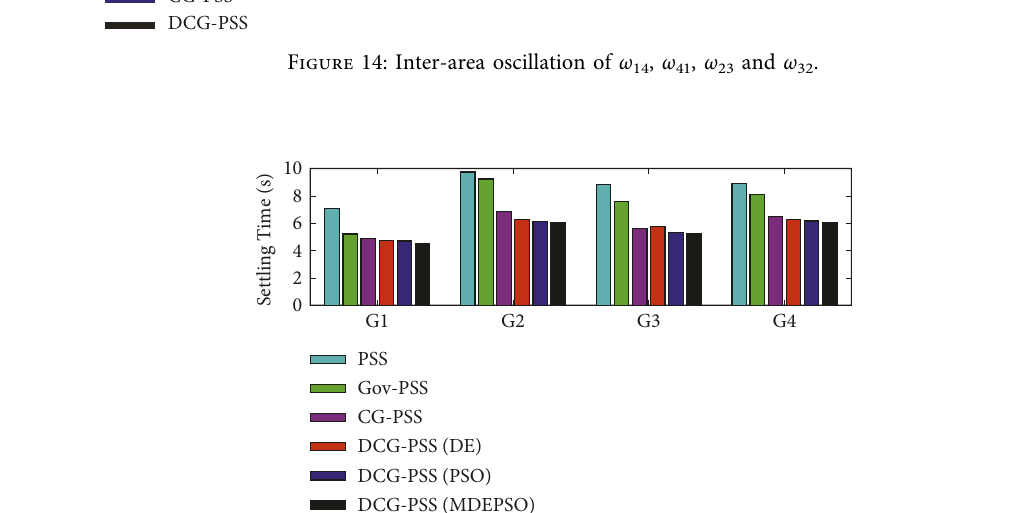
Figure 15: Settling time comparisons with different control